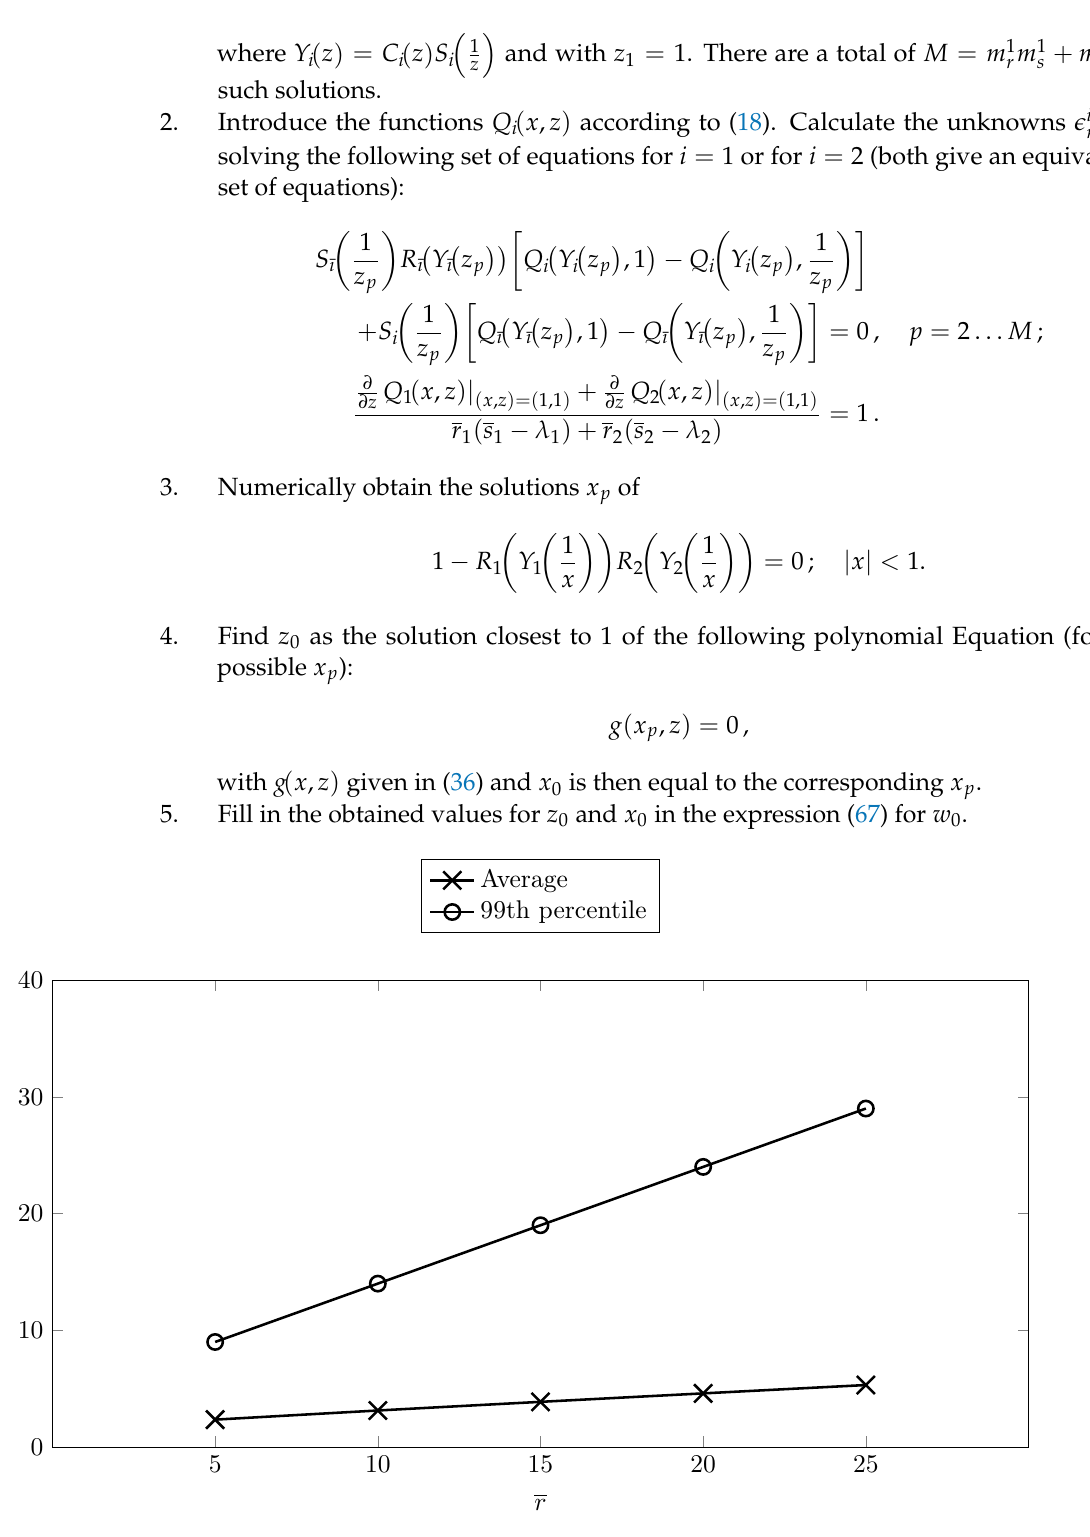
Figure 3. Average and 99th percentile of the delay for the example of Section